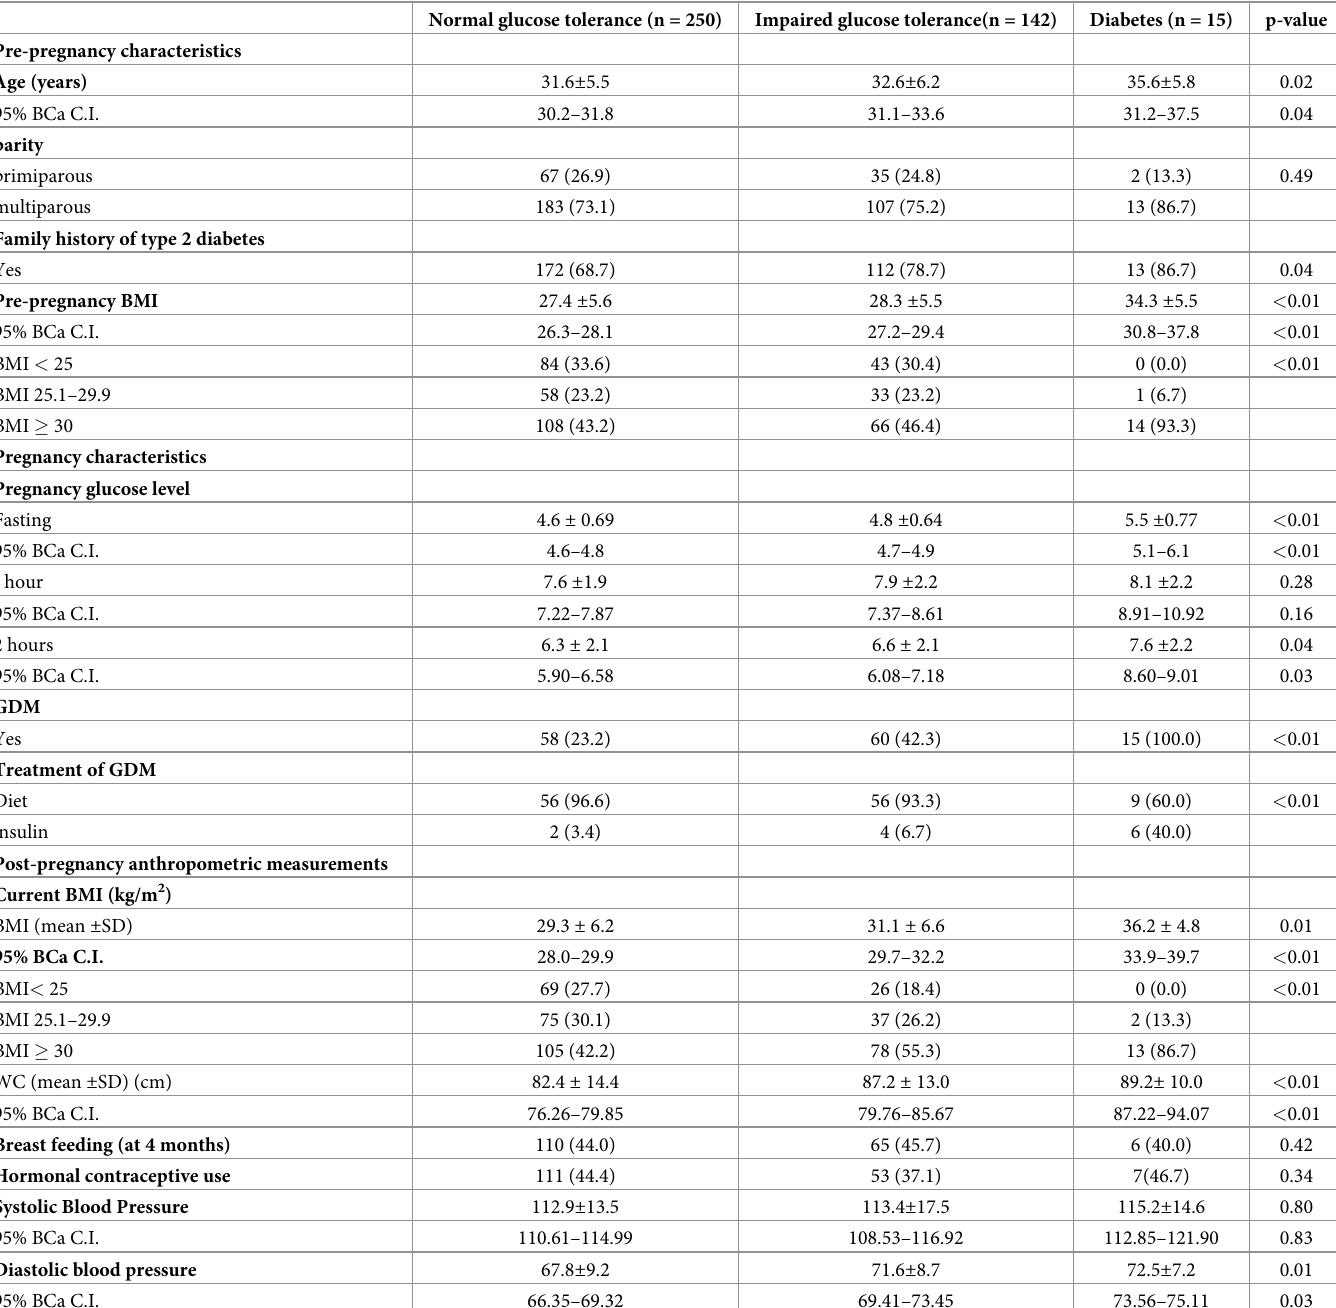
Table 2. Comparison of characteristics of women with normal glucose tolerance, impaired glucose tolerance and